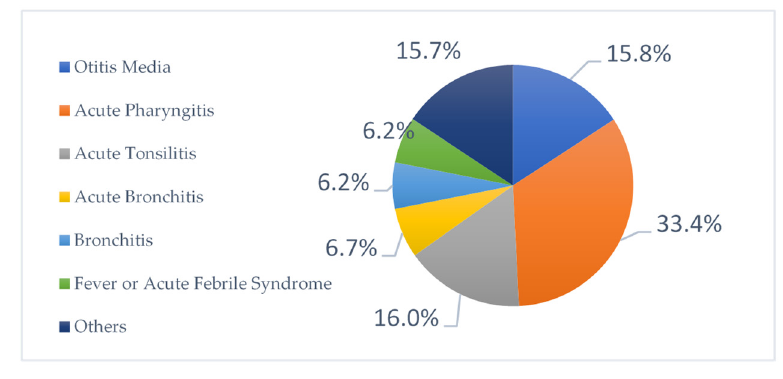
Figure 5. Distribution of diagnoses for which antibiotics were prescribed.